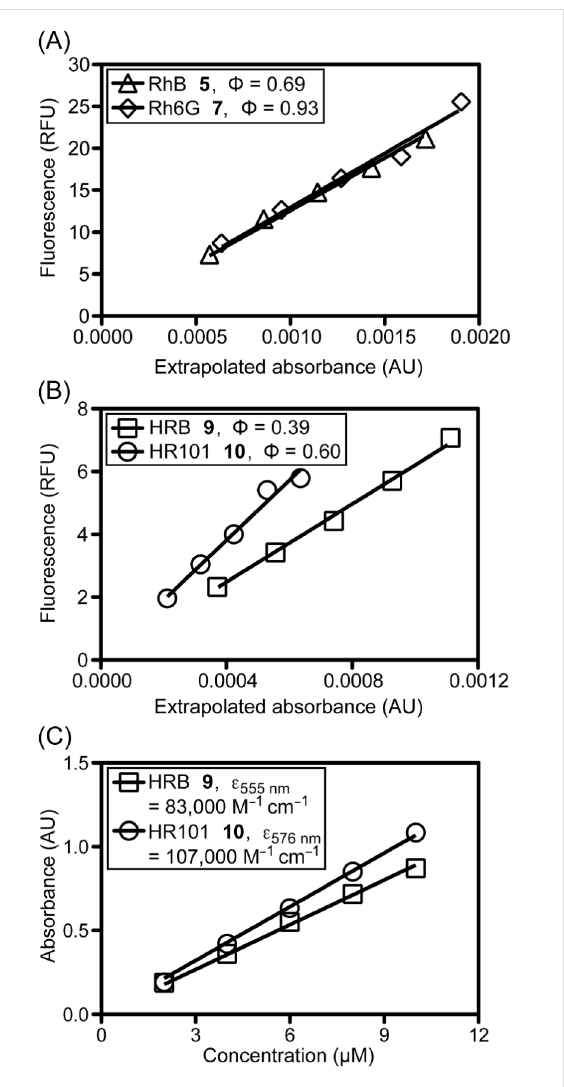
Figure 3: Linear regression used to determine spectroscopic parame- ters of HRB 9 and HR101 10 in MeOH. Panels A and B: Determin- ation of quantum yields relative to rhodamine B ( 5 ) [44] and rhodamine 6G ( 7 ) [45]. Panel C: Quantification of molar extinction coefficients.